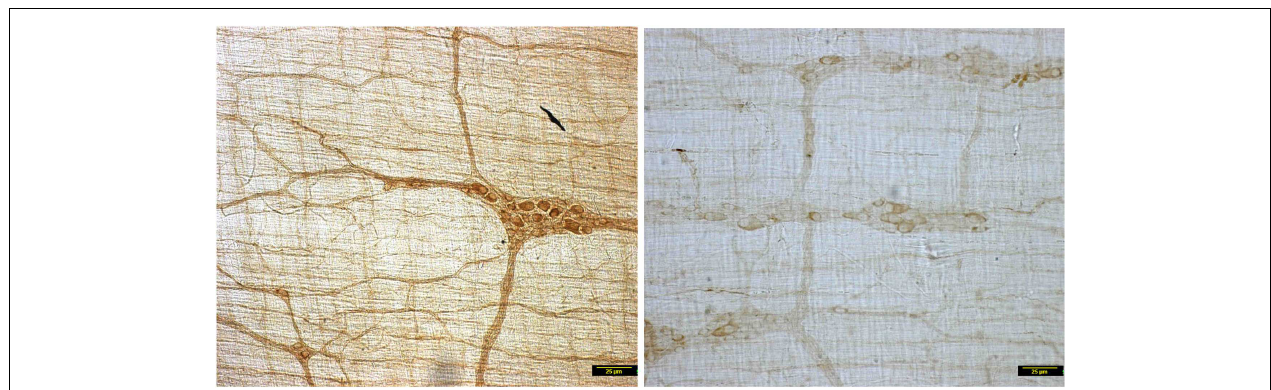
FIGURE 1 | Low power micrographs from jejunal whole mounts of vehicle treated (left) and streptozotocin induced diabetic rats (right) . Note the obvious differences in DAB staining intensity of myosinVa between the two panels. Scale bar, 25 µ m.